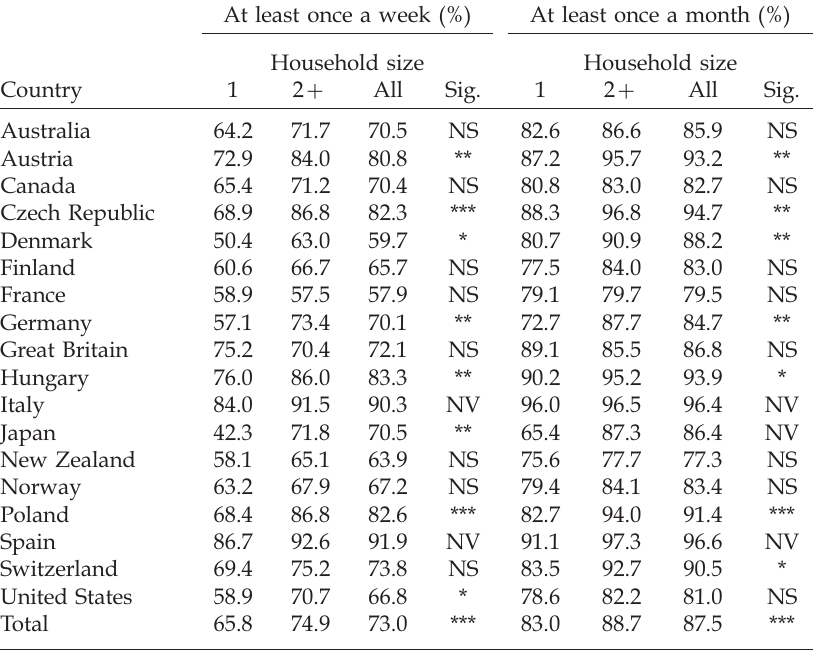
Table 1. Proportion ha v ing weekly/monthly face-to-face contact with their adult child by household size and country At least once a week (%) At least once a month (%) Household size Household size Country 1 2 (cid:3) All Sig. 2 (cid:3) All